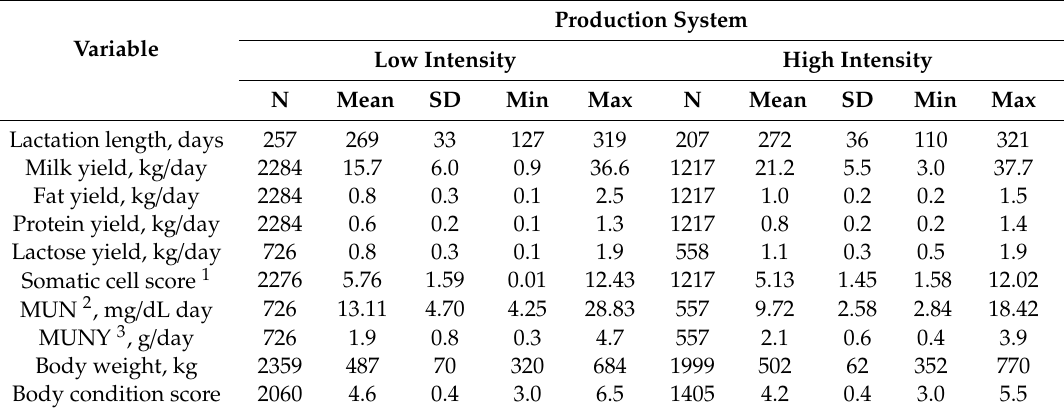
Table 2. Descriptive statistics of the lactation length records and herd test records of the yield of milk (MY), fat (FY), protein (PY) and lactose yields (LY), somatic cell scores (SCS), milk urea nitrogen (MUN), MUN yield, body weight, and body condition score (BCS) of grazing cows throughout a full lactation in two contrasting pasture-based dairy production